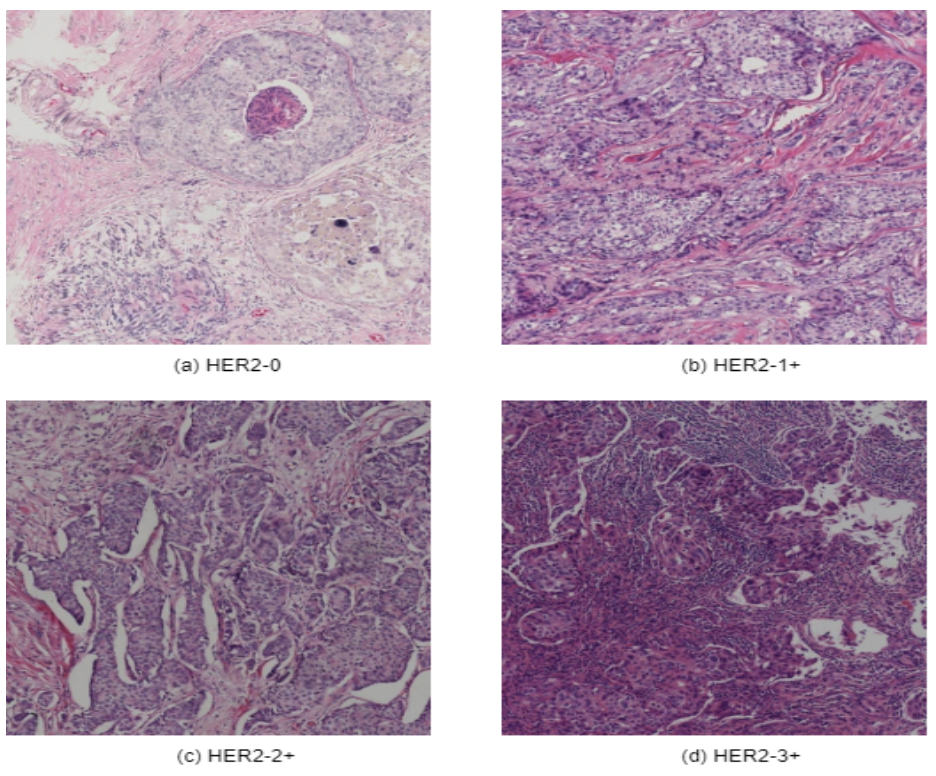
Figure 1. Sample images of each of the class of BCI-H&E dataset: ( a ) HER2-0, ( b ) HER2-1, ( c ) HER2-2, and ( d )